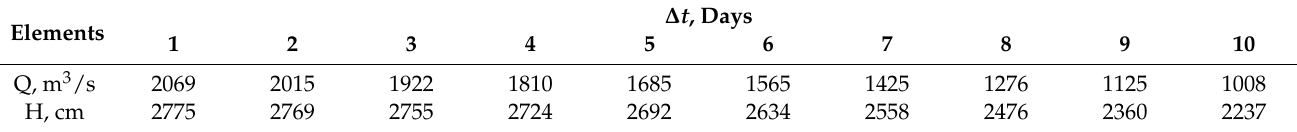
Table 3. The number of gauging stations with satisfactory forecasts of various lead